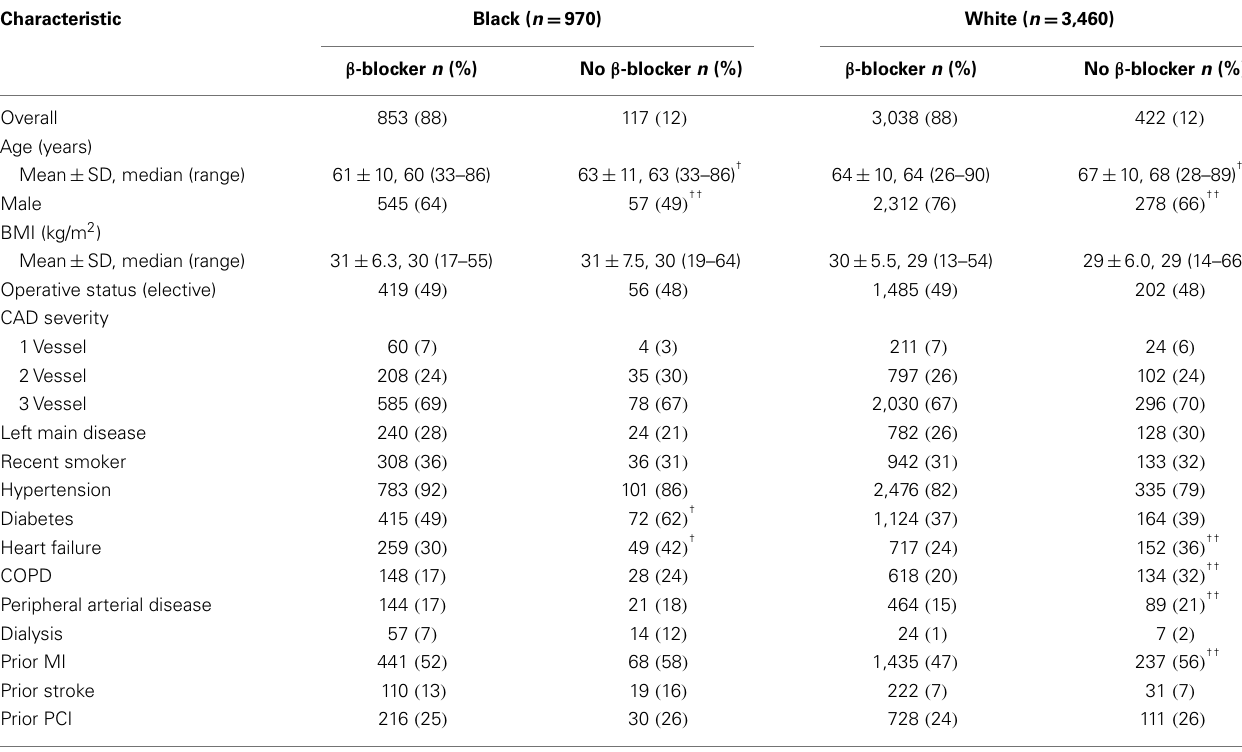
Table 1 | Patient characteristics .